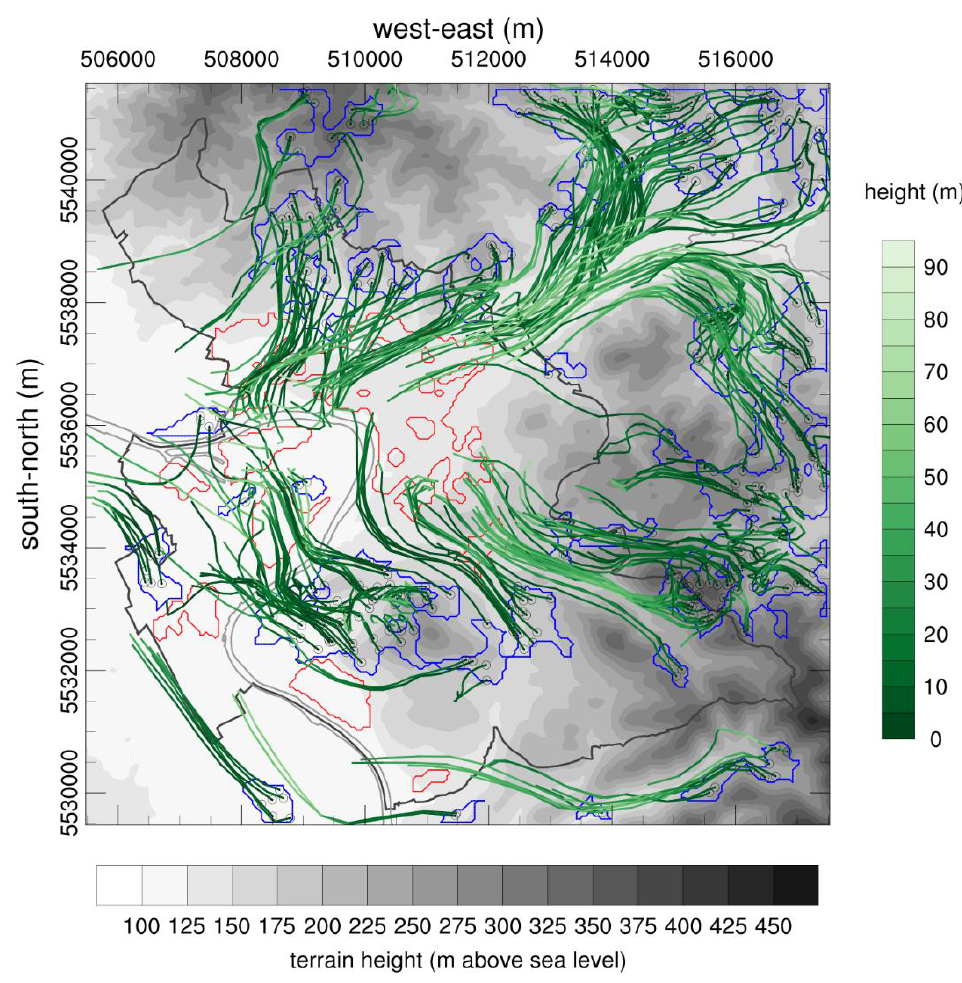
Figure 11. Forward trajectory map of the 12 km × 12 km subdomain from 23:00 to 01:00 CEST with trajectory heights above ground level in green color shading. Trajectories are released in the cold air formation areas (blue) identified by z-transformation. Additionally shown are the thermal hot spots in red, rivers in light grey, the city border of Aschaffenburg in black and terrain elevation in grey color shading.